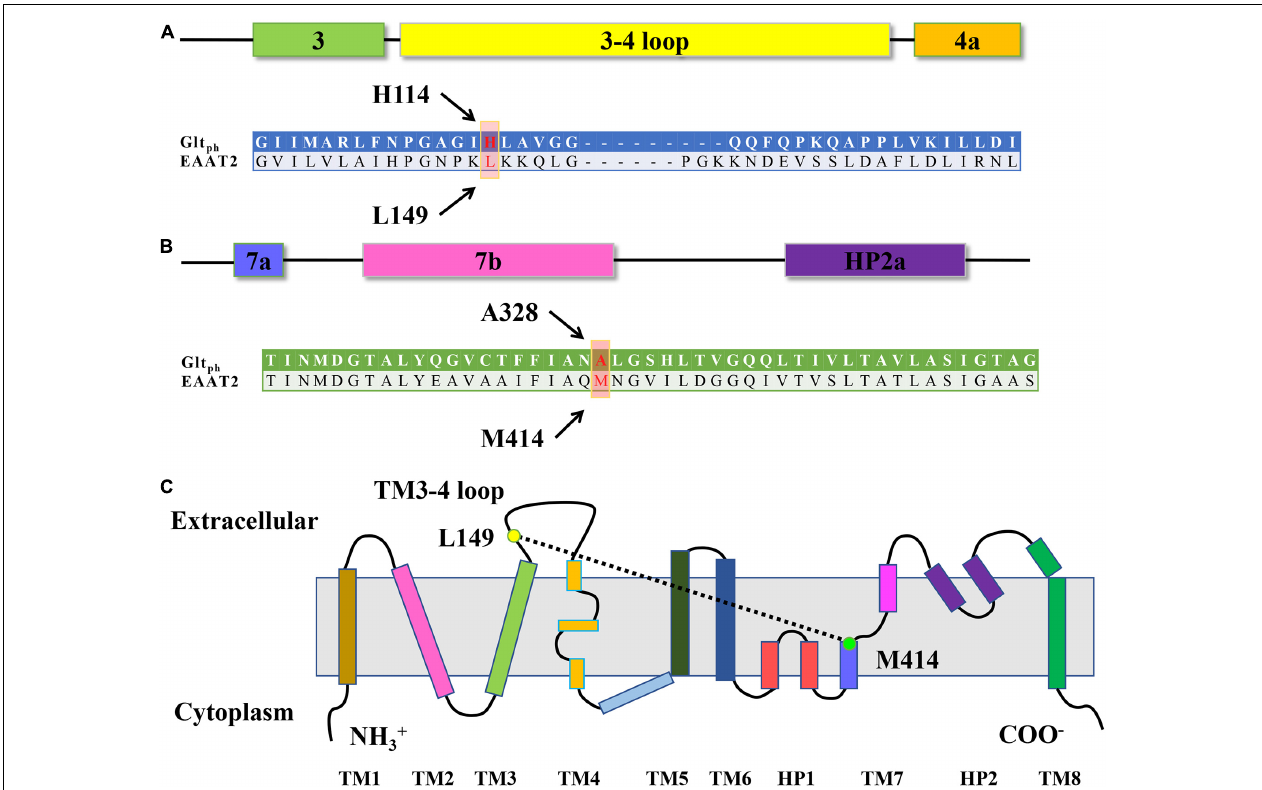
FIGURE 1 | Sequence alignment and EAAT transmembrane topology. (A,B) Sequence alignment of the TM3-TM4 loop (A) and TM7 (B) of Glt Ph and EAAT2. The arrows show the residues L149 and M414 of EAAT2, which occupy the positions homologous to H114 and A328 in Glt Ph . (C) Schematic of EAAT transmembrane topology. Yellows dots show the approximate locations of the residue L149 and M414 of EAAT2.